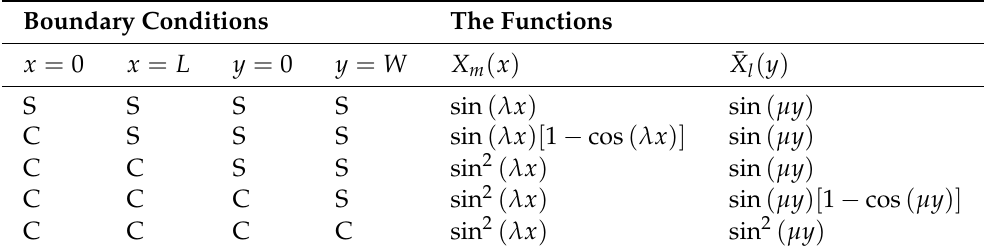
Table 1. The admissible functions X m ( x ) and ¯ X l ( y )